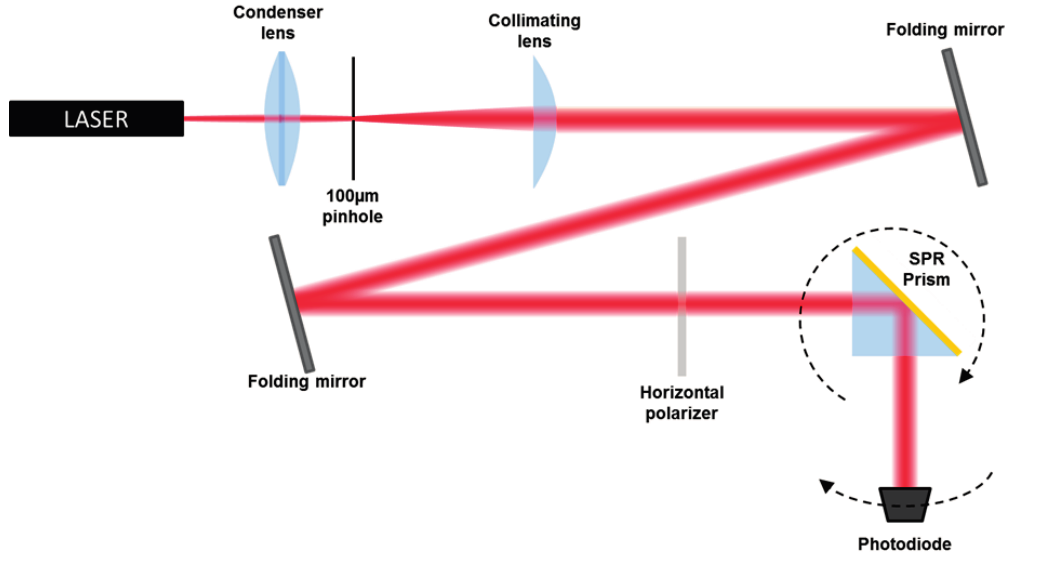
Figure 2. Experimental Kretschmann set-up